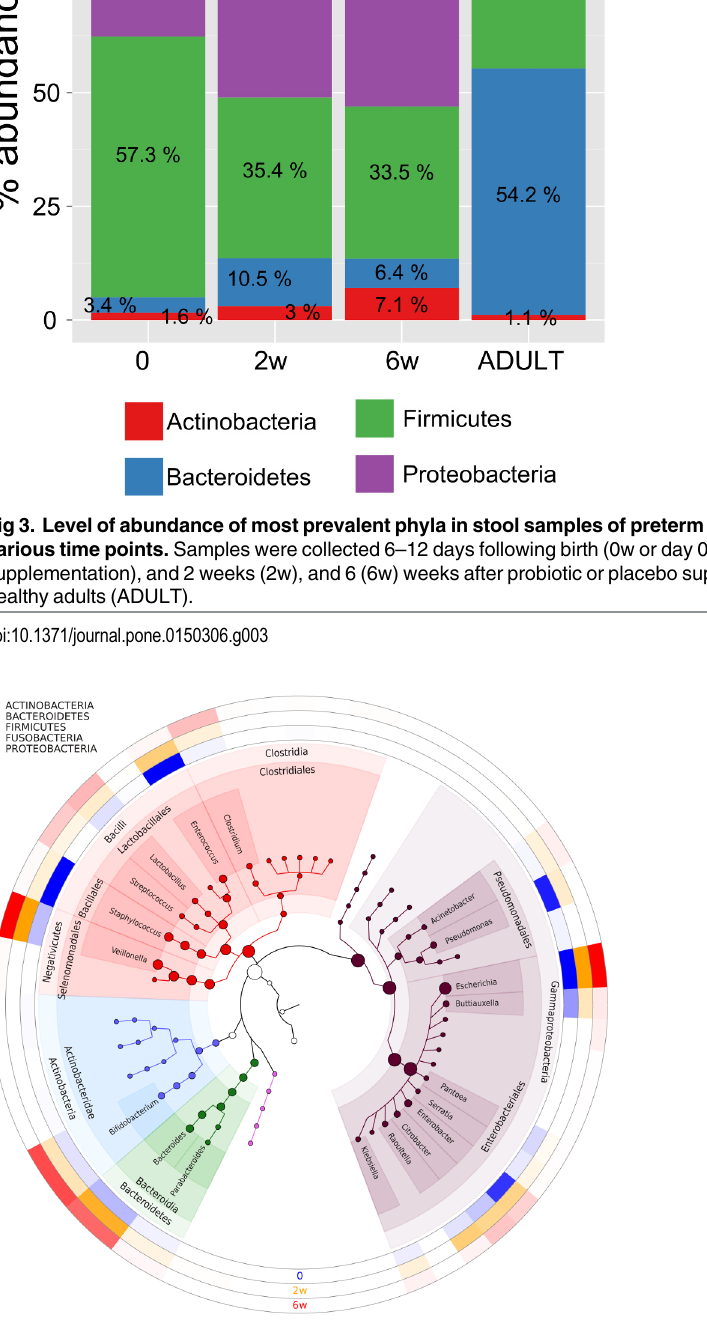
Fig 4. Composition of the gut microbiome at the early phase of development dominated by four phyla: Actinobacteria , Bacteroidetes , Firmicutes , and Proteobacteria . A phylogenetic tree demonstrating bacterial abundance is present in the center. Each circle depicts a heatmap, representing a one-time probe. The more intense the color on the heatmap, is, the larger the percentage of reads from a given genus